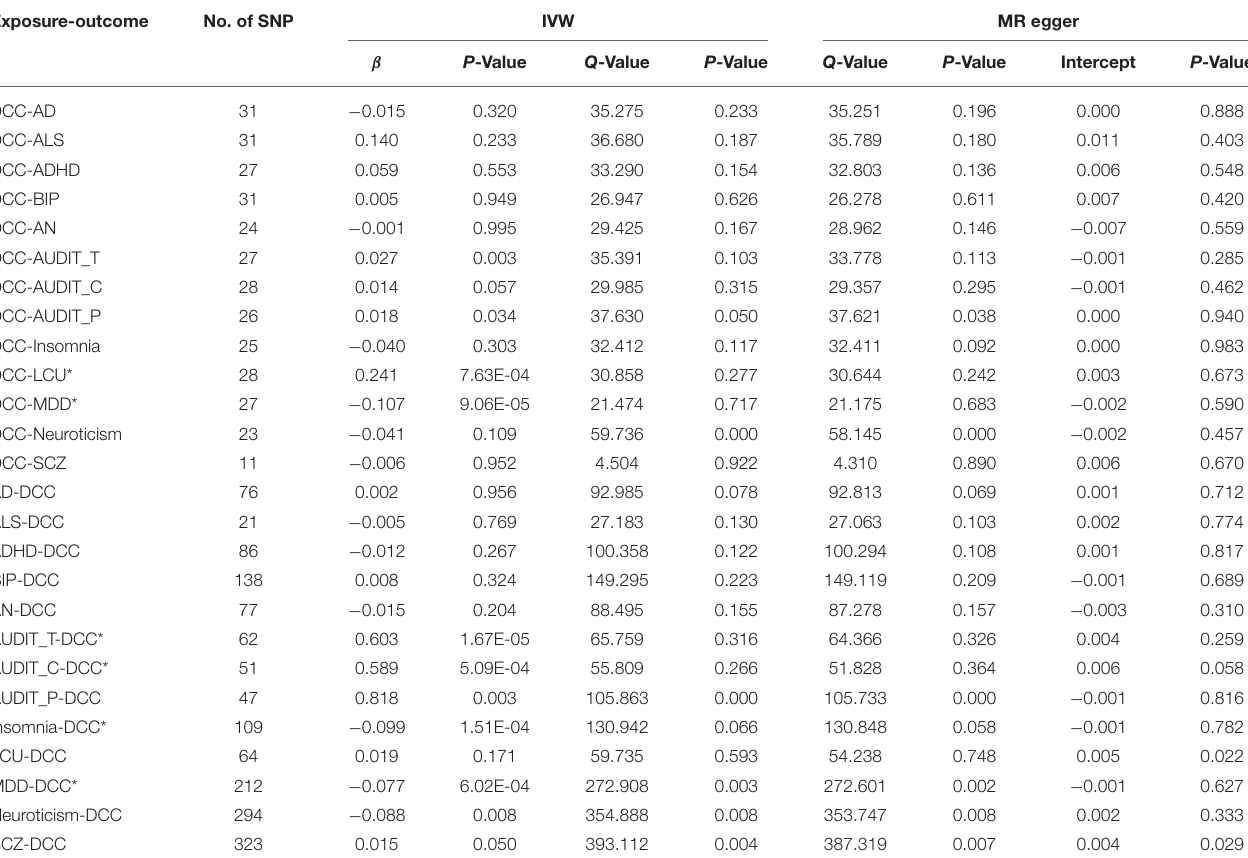
TABLE 3 | The bidirectional MR analysis of decaffeinated coffee consumption and neuropsychiatric traits.